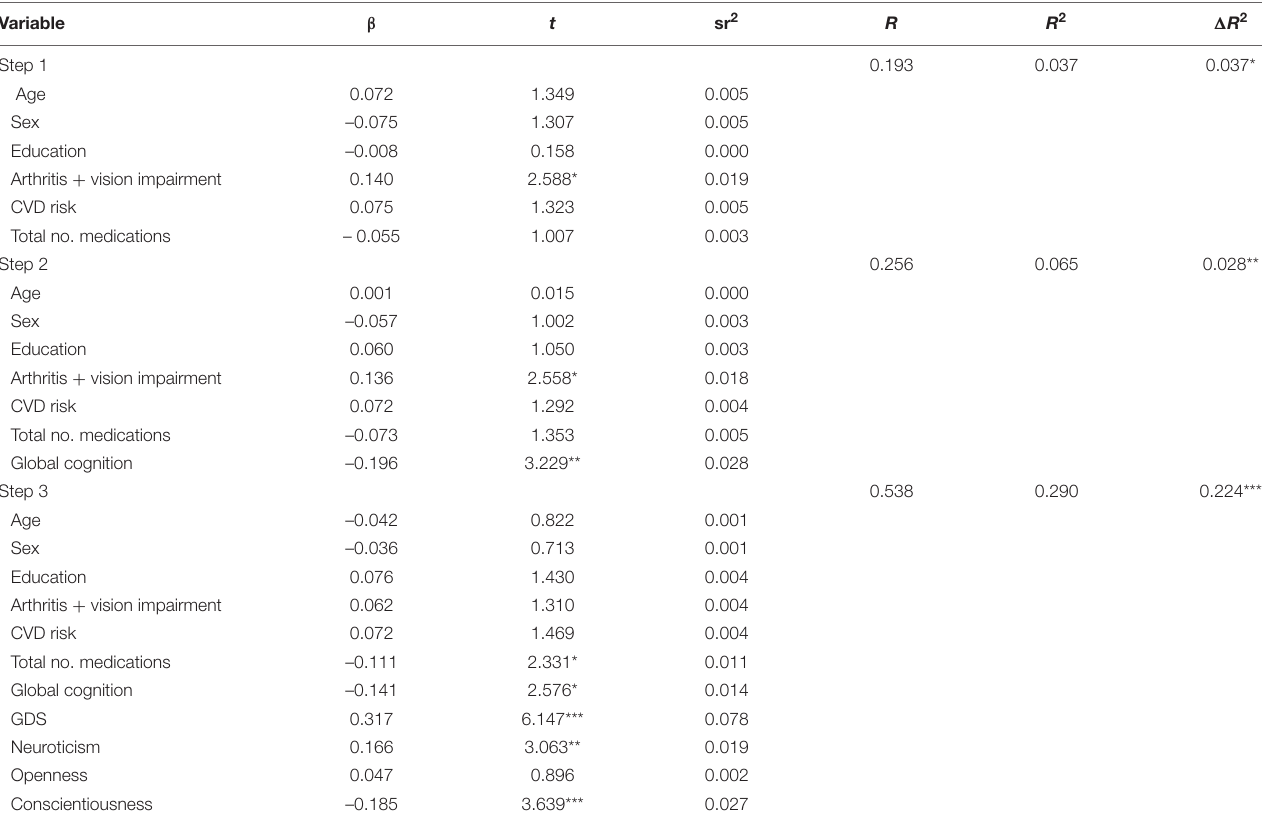
TABLE 2 | Hierarchical linear regression predicting self-report Bayer-IADL.